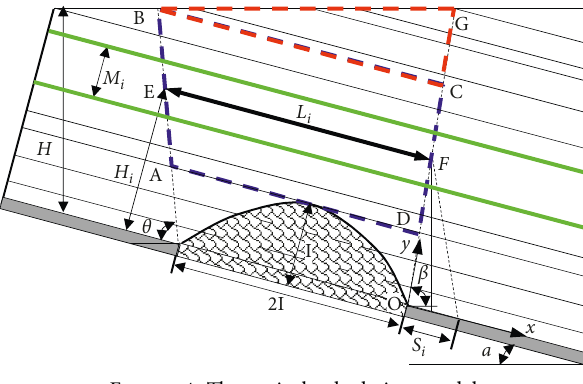
Figure 4: Theoretical calculation